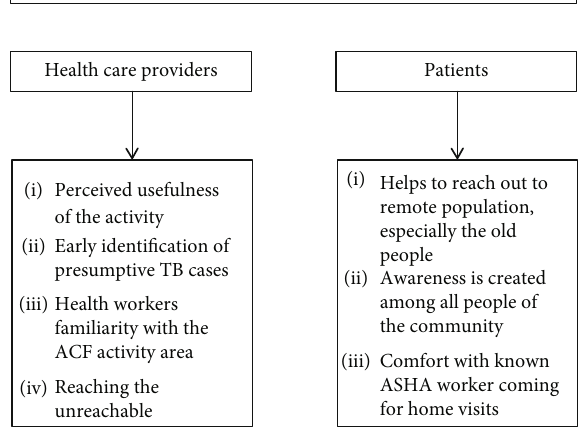
Figure 2: Enablers for ACF activity as perceived by health care providers and